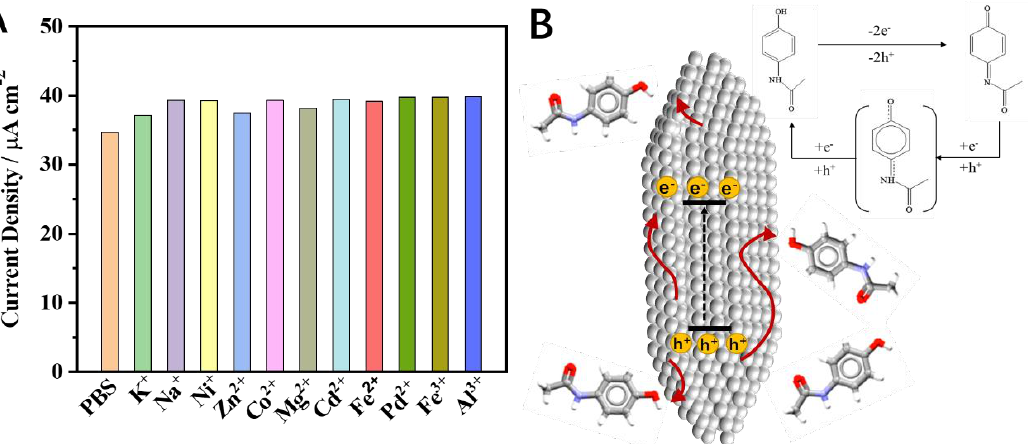
Figure 6. ( A ) Anti-interference experiment of different ions in 100 µM paracetamol with different metal ions. The concentration of the metal ions is 0.10 M. The data of current density are collected by DPV. ( B ) Mechanism of the electrochemical oxidation and reduction of paracetamol.